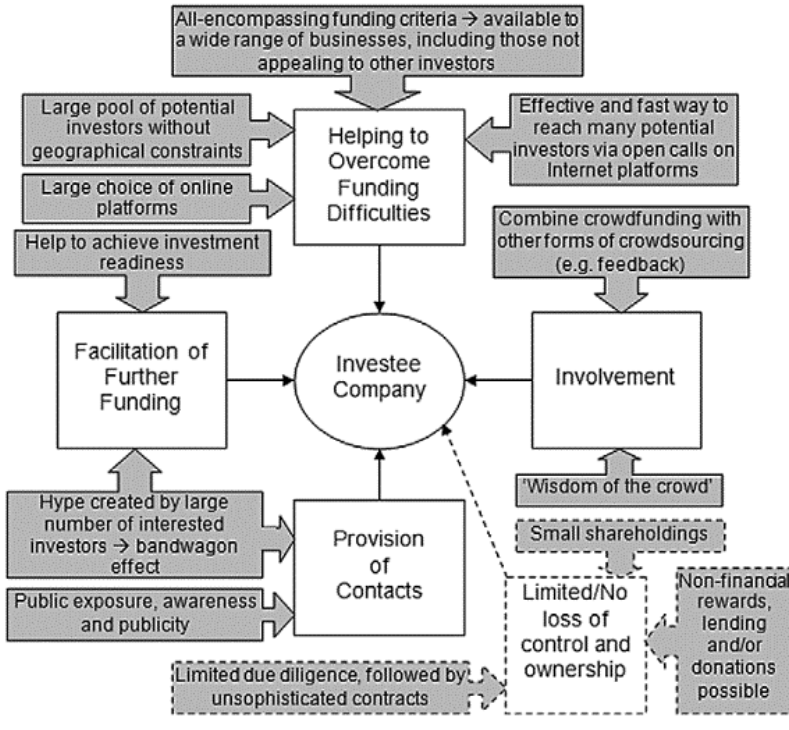
Figure 5. The benefits of crowd funding